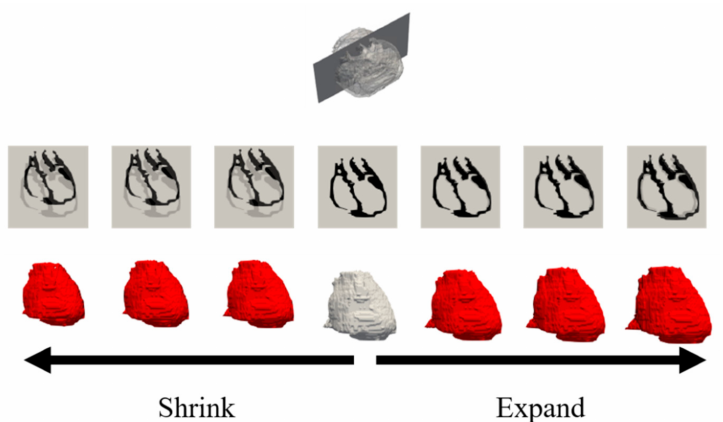
Figure 9. Variations in TARO cardiac model: scaling with a value of ± 2%, ± 5%, and ± 10% of the original volume displayed in ascending order from left to right. Upper images are coronal cross-sectional slices, and bottom images are volume